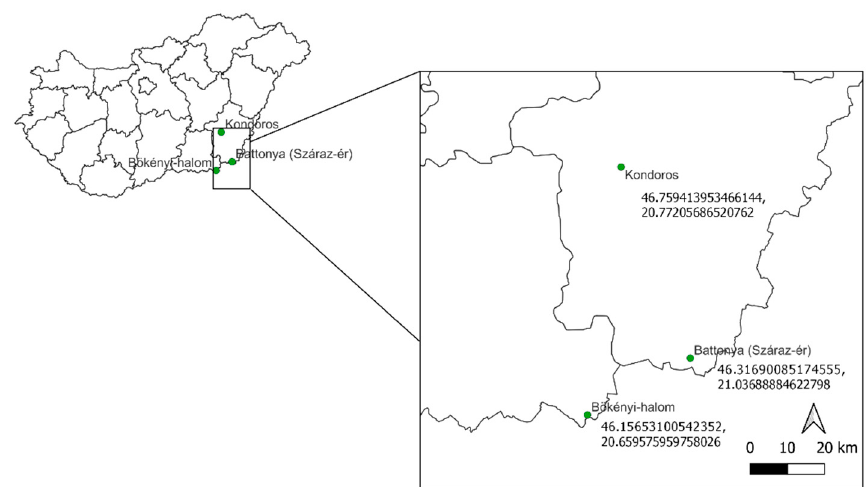
Figure 1. Map of the sampled verges .